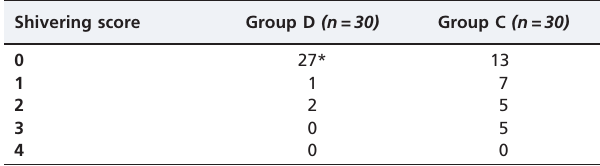
Table 2 - Perioperative shivering scores of the patients. Shivering